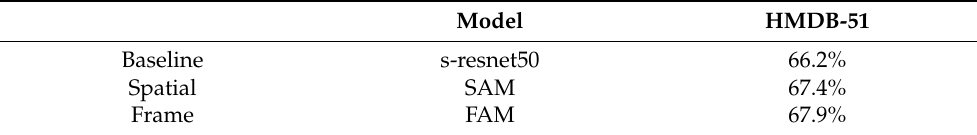
Table 1. The validation of the attention module, embedding module into baseline.